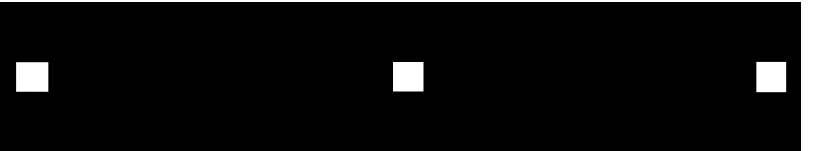
Figure 5. Visualization of visual stimuli appearing on the screen during computer-based tests intended for measuring the time of simple and complex reactions.